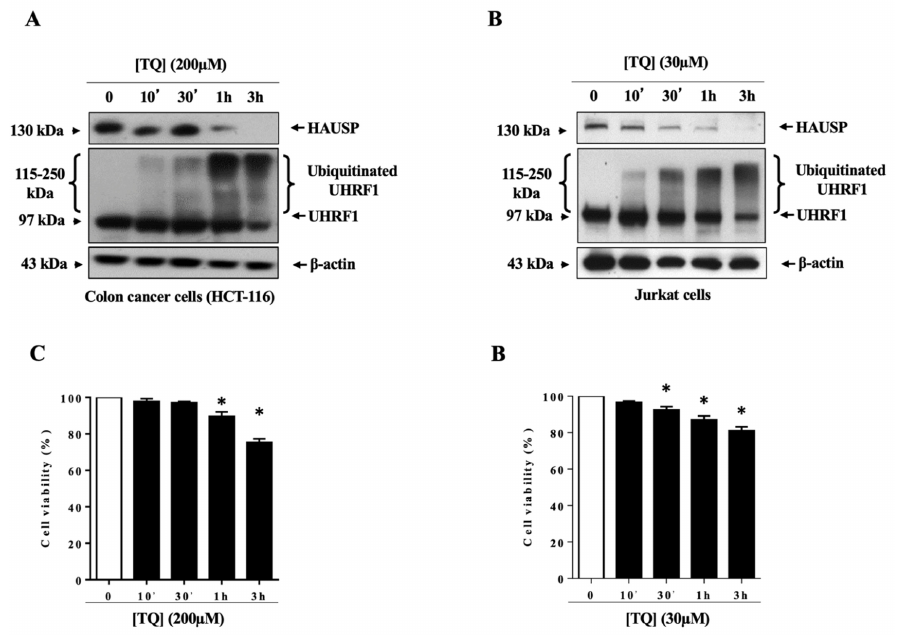
Figure 2. Time course effect of TQ on HAUSP, UHRF1 and ubiquitinated UHRF1 and cell proliferation. Human colon cancer cells (HCT-116) ( A , C ) and Jurkat cells ( B , D ) were exposed to 200 μ M and 30 μ M TQ, respectively, for different times. The expression of HAUSP and UHRF1 was analyzed by means of Western blotting, as described in the Materials and Methods. The cell proliferation rate was assessed via the WST-1 assay. Values are shown as means ± S.E.M of three different experiments. * p < 0.05 versus control.